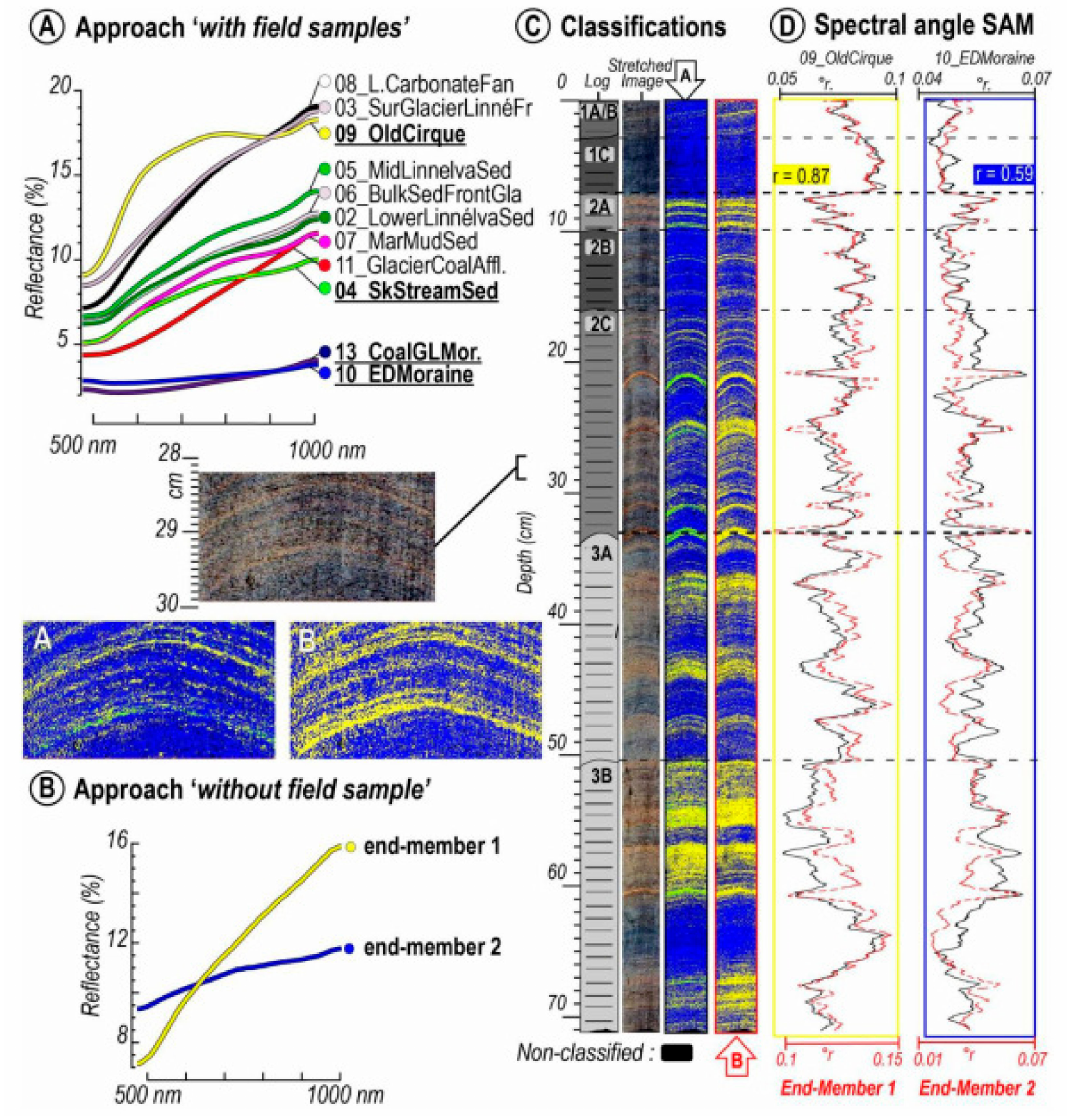
Figure 7. Example of hyperspectral image classification techniques to distinguish sedimentary sources at Lake Linn é , Svalbard [55]. ( A ) Reflectance spectra of rock and sediment samples obtained from the catchment area. ( B ) Endmember spectra identified in the sediment core. ( C ) Core image, and classification maps based on similarity to spectra in ( A , B , D ) Downcore profiles of similarity scores (spectral angle) for endmembers 1 and 2, as well as the field samples most similar to those two endmembers. Endmember 1 is composed of fine-grained clastic sediments, whereas Endmember 2 represents sediments with greater organic matter content, and is similar to field samples taken from coal-rich deposits in the catchment area (13_CoalGLMor and 10_EDMoraine). Reprinted from Van Exem et al. [55] with permission from